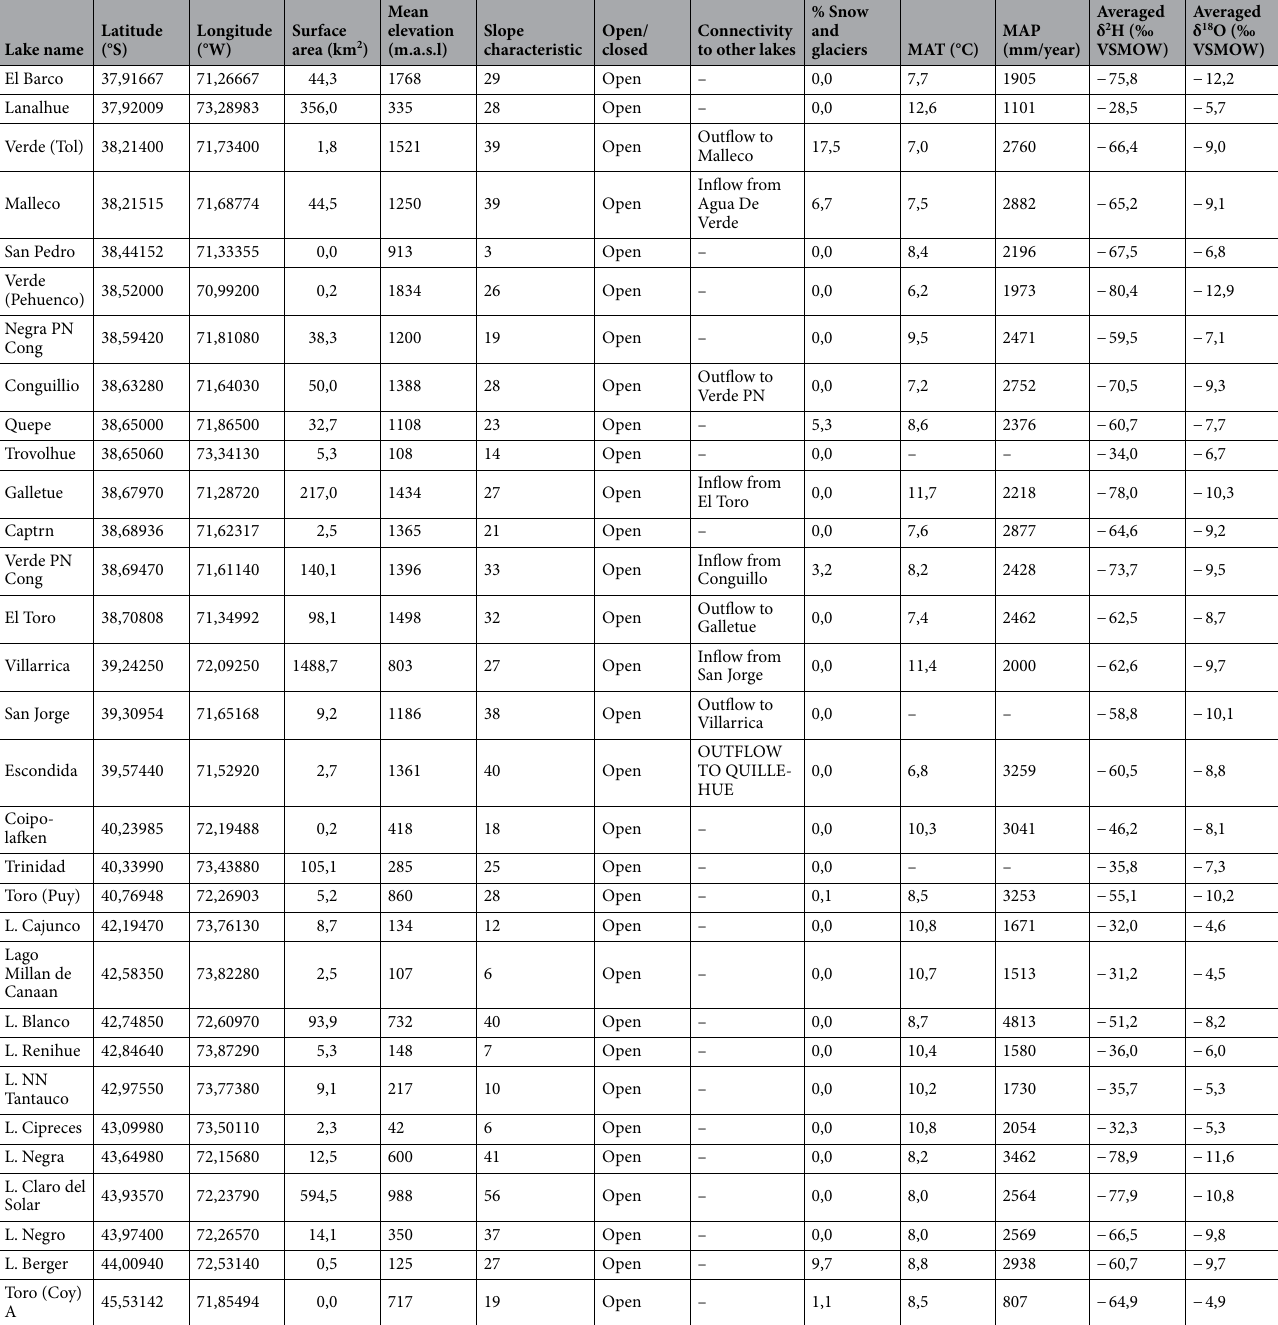
Table 1. Lakes with physical, climatological, and isotopic data from this